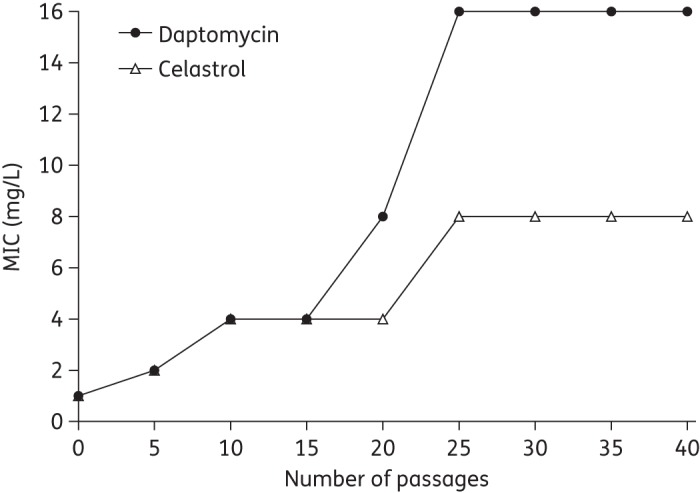
Selection of daptomycin- and celastrol-resistant mutants of S. aureus SH1000. Results are representative of experiments carried out on eight independent occasions using the extended gradient MIC method.23